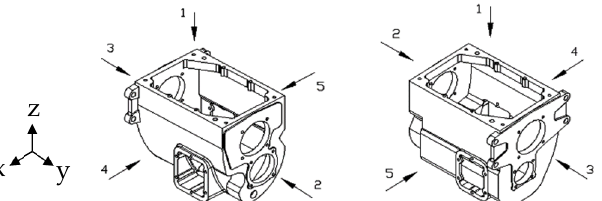
Figure 1. An automobile gearbox housing with five numbers indicating five machining orientations respectively.